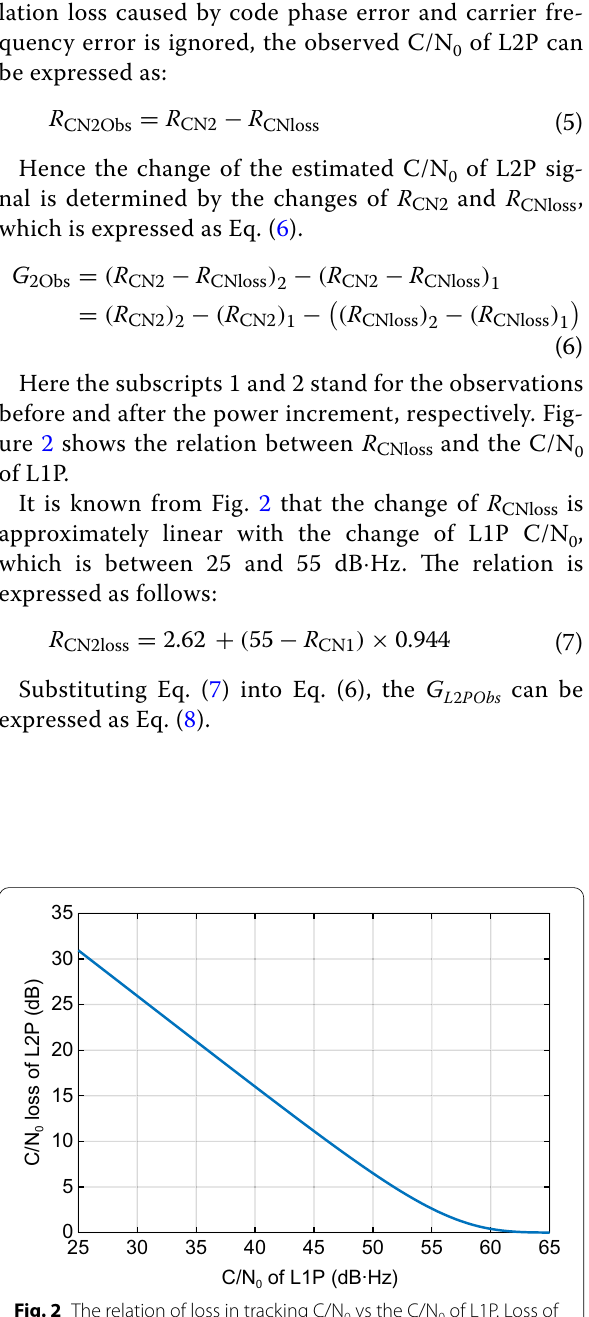
Fig. 3 The power enhancement and attack mission in April 2018. Yellow and orange blocks indicate the period of power enhancement while the red block shows the time of the attack